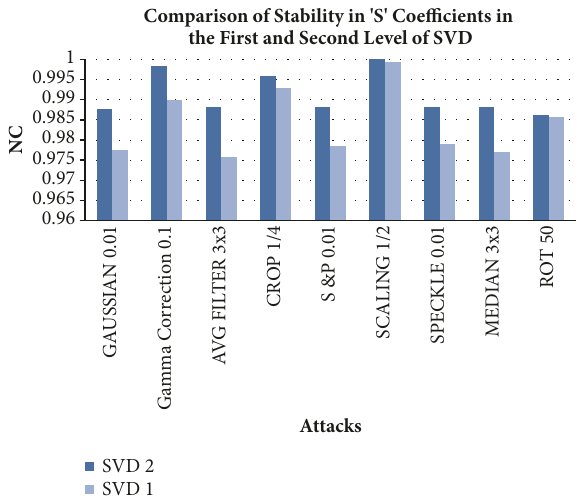
Figure 6: Comparison of stability in “S” coefficients in the first and second level of SVD for 9 images 1024 ∗ 1024.